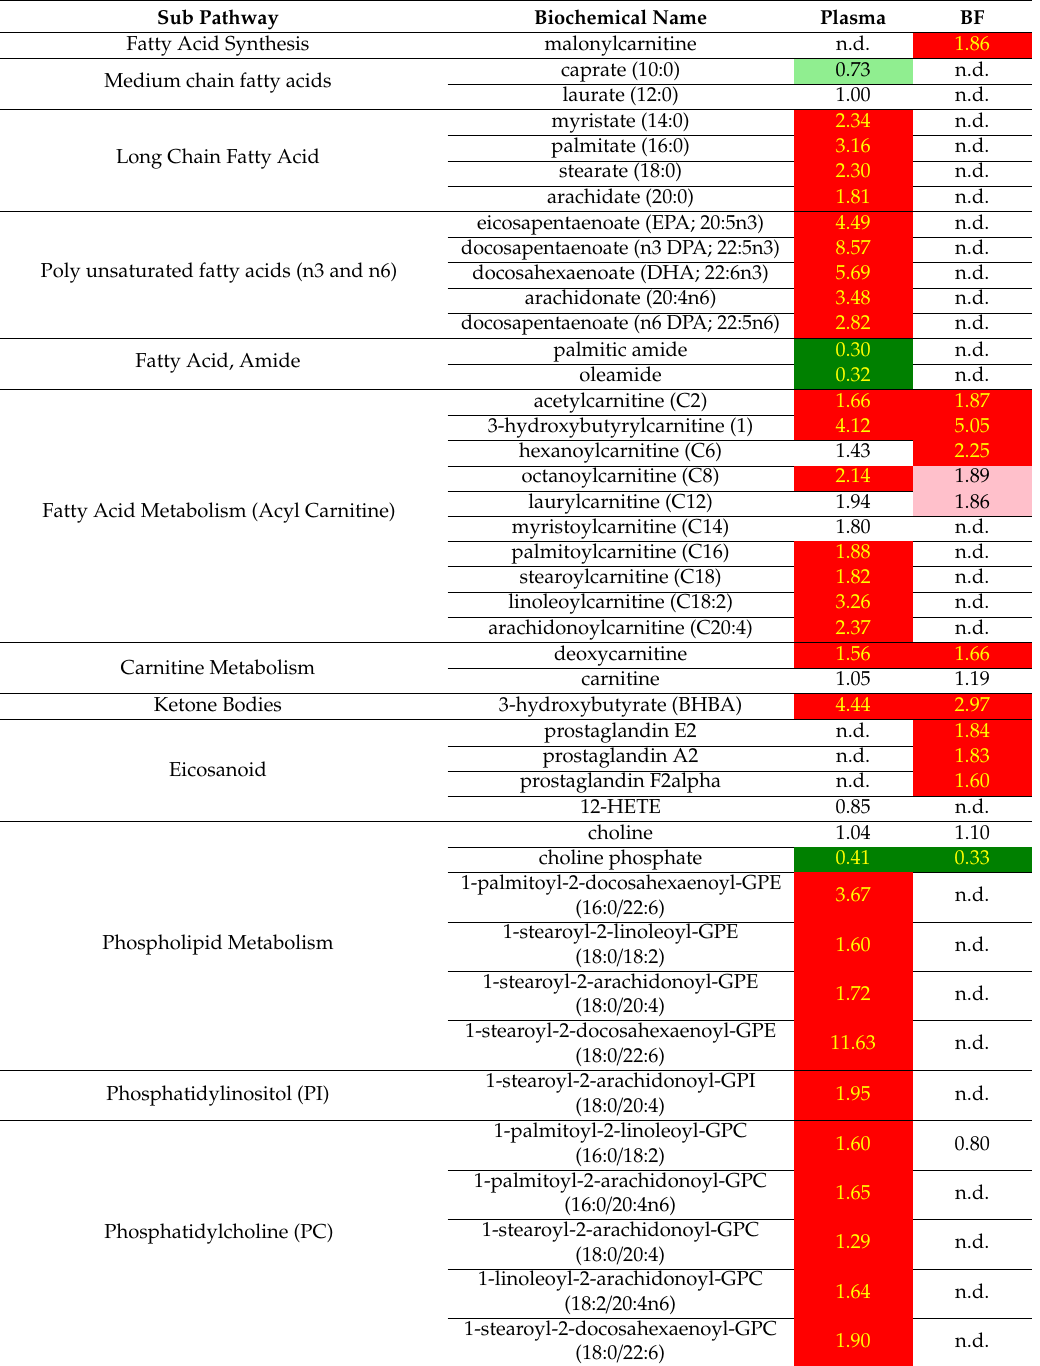
Table 3. List of selected lipids that were detected in maternal plasma and blastocysts cavity fluid (BF) in non-diabetic and diabetic